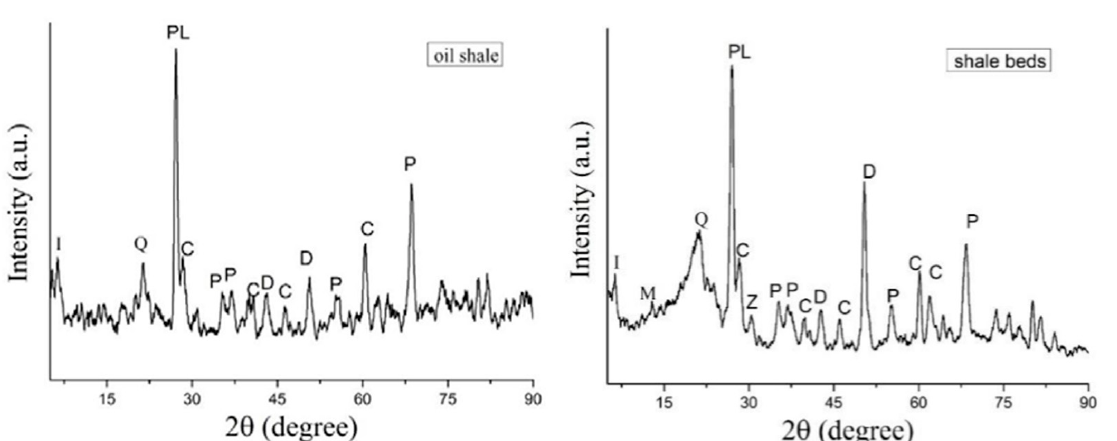
Figure 3. XRD spectra of the oil shale and shale beds. I, illite; Q, quartz; PL, plagioclase; C, calcite; P, pyrite; D, dolomite; M, montmorillonite; Z, zeolite.